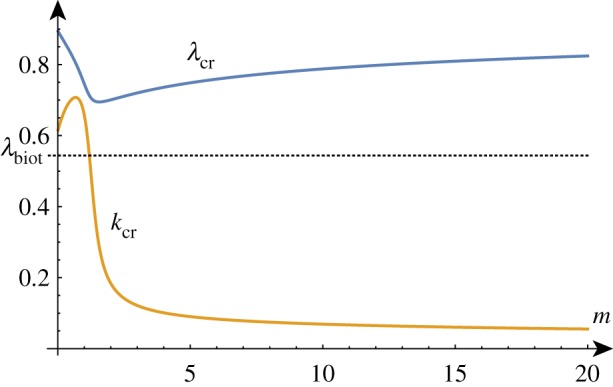
kcr and λcr as functions of m for β = 10. (Online version in colour.)